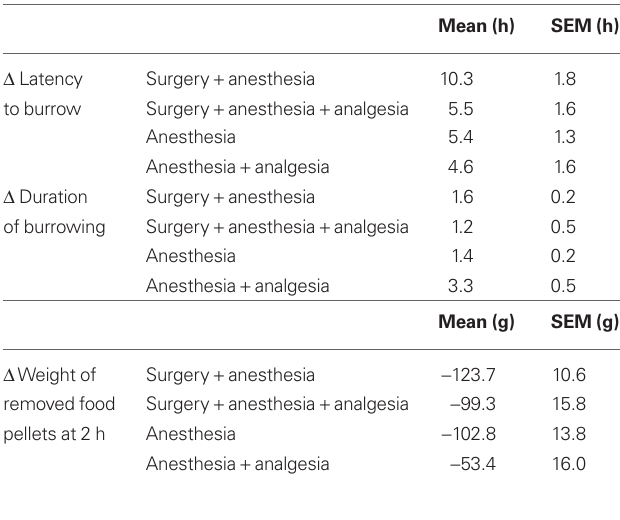
Table 2 | Delta ( ∆ ) values of latency to burrow, duration of burrowing, and weight of removed food